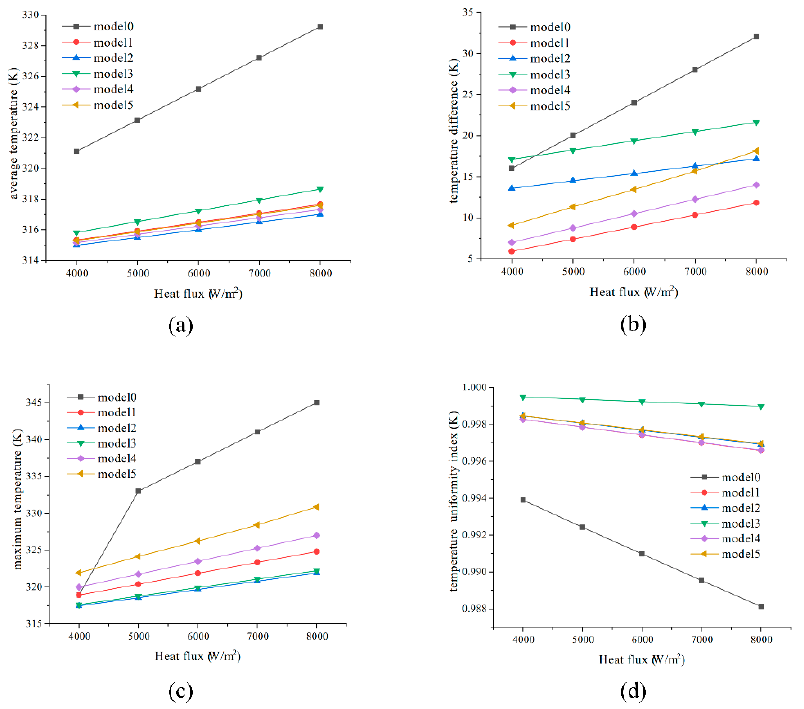
Figure 10. Effect of heat flux on heat transfer characteristics. ( a ) Average temperature, ( b ) temperature difference, ( c ) maximum temperature, ( d ) temperature uniformity